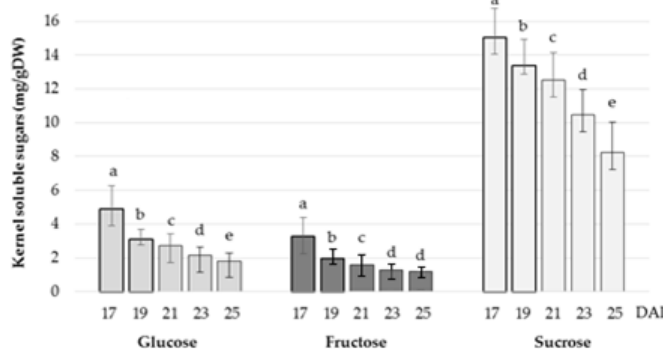
Figure 1. Kernel glucose, fructose and sucrose content changes during su1 sweet corn maturation. Histograms show mean values ± standard deviation across five hybrids and two years. The different letters indicate significant differences among the harvest dates in each soluble sugar ( p <